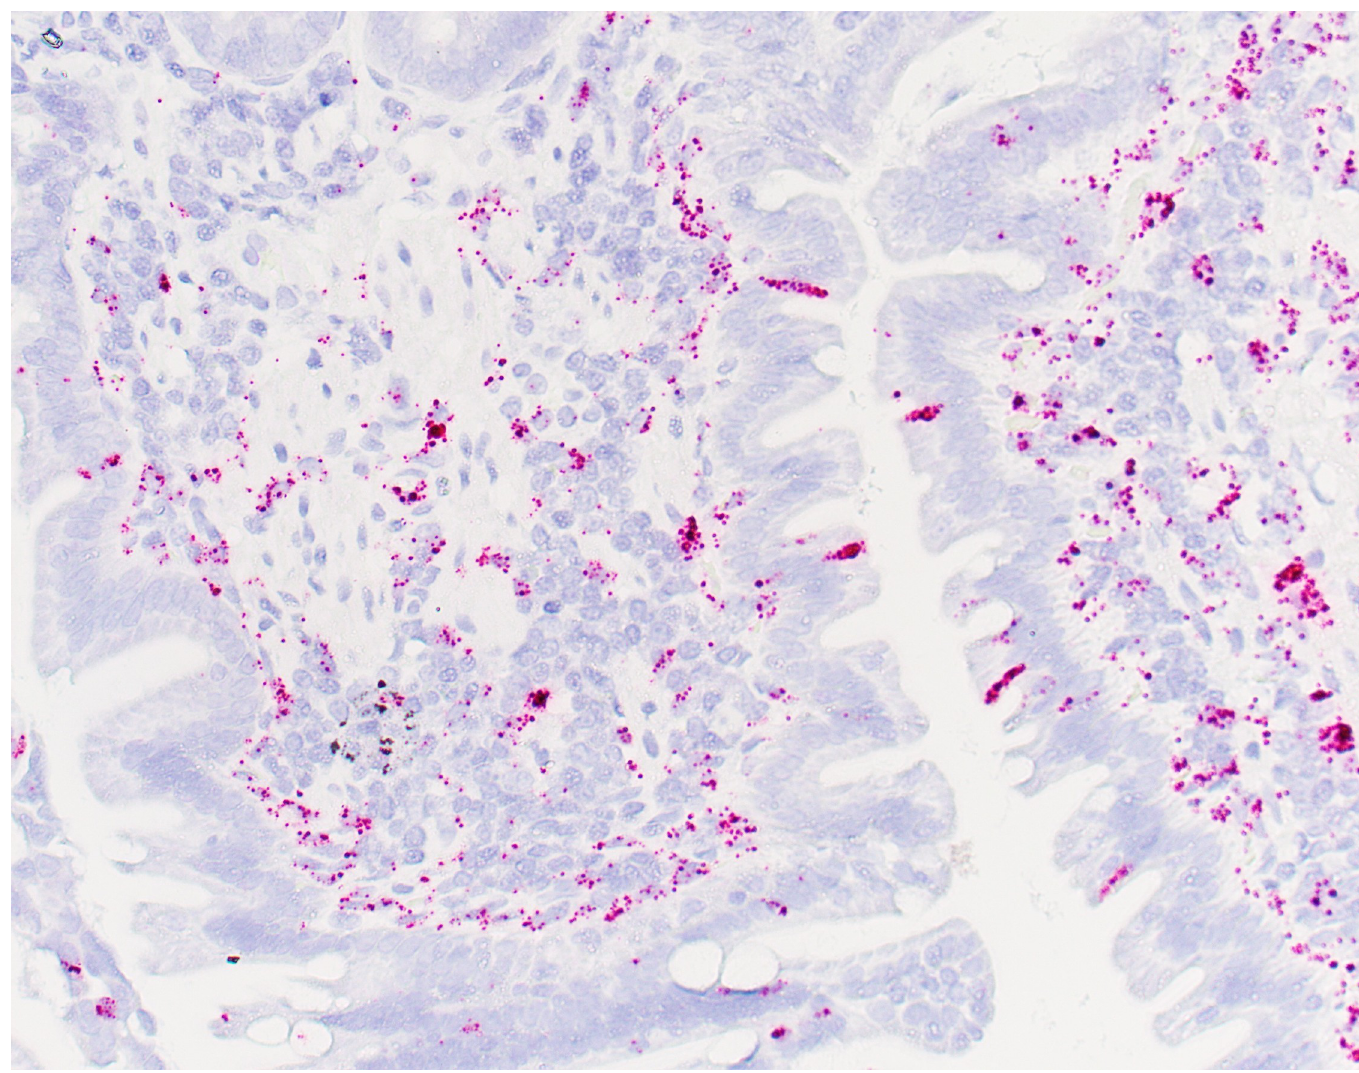
Fig 4. RNA in situ hybridization of IDO-1 mRNA in the duodenal mucosa of a healthy Beagle control dog.